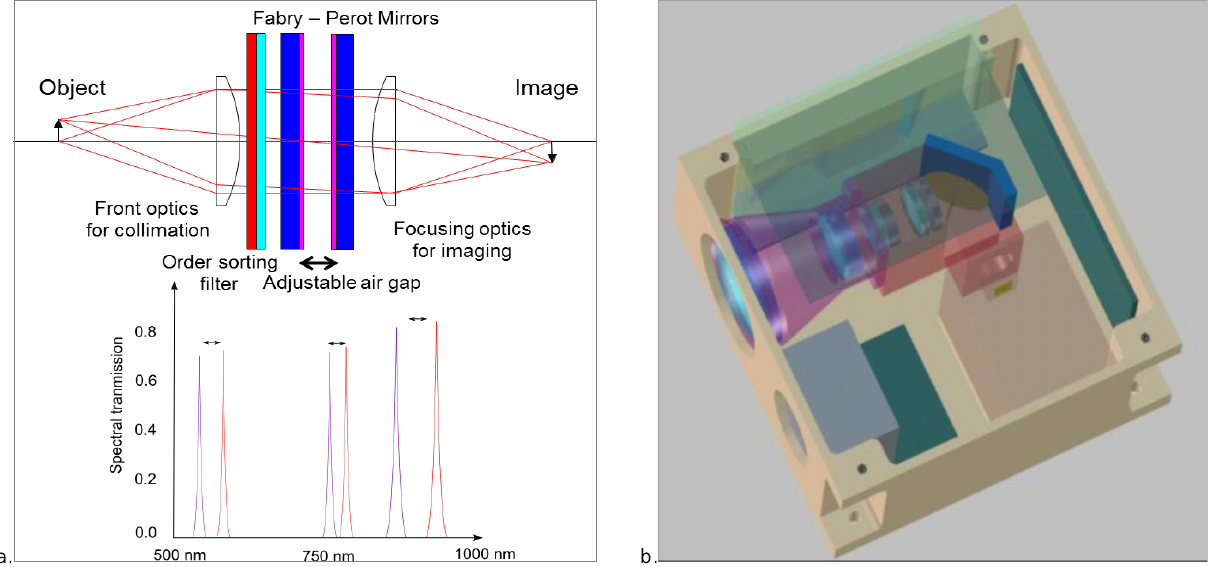
Fig. 2. (a) The Fabry–Perot interferometer concept at work; the change in the Fabry–Perot mirror interdistance causes a change in the spectral bandwidth to the imaging CMOS camera. (b) Structural view of the spectral imager instrument, the larger instrument representing the spectral imager, while the smaller (beneath) instrument is the VIS-camera (N¨asil¨a et al.,